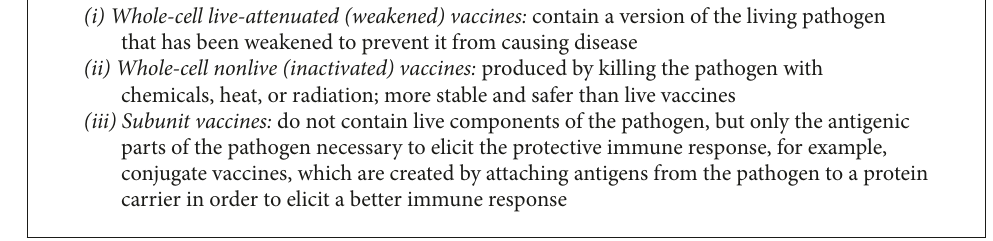
Table 1: Rates of vaccine-preventable disease in Kuwait.